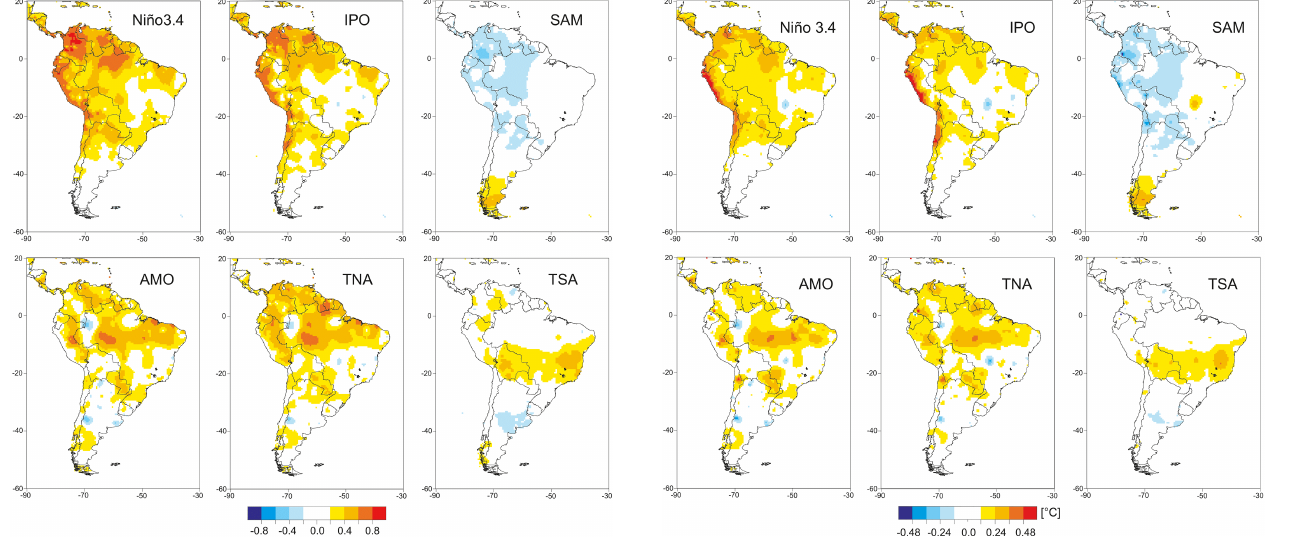
Figure 2. Correlation of annual mean temperature over South America with climate modes Niño3.4, IPO (Interdecadal Pacific Os- cillation), SAM (Southern Annular Mode), AMO (Atlantic Multi- decadal Oscillation), TNA (tropical North Atlantic SST), and TSA (tropical South Atlantic SST). High positive values of the correla- tion coefficient indicate both increasing and decreasing values of the mode in question and the local temperature at each grid cell. High negative values indicate that the increasing (decreasing) mode in question causes a significant decrease (increase) in temperature at the grid cell. Gridded temperature fields are from the University of Delaware (1958–2008). Only correlations in excess of ± 0.2 are shown (roughly the threshold of the 95% significance level).